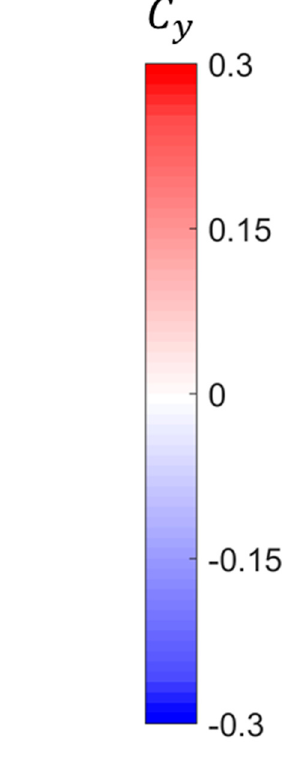
Figure 5. Mean location of the two vortex cores in each test case, coloured by C y